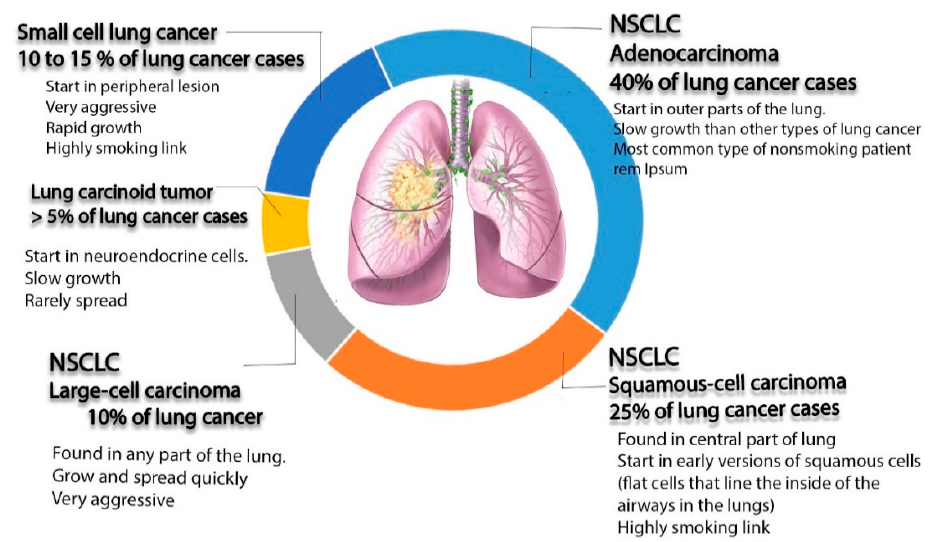
Figure 1. Schematic diagram illustrating different types of lung cancer (non-small cell lung cancer (NSCLC), small cell lung cancer (SCLC), and lung carcinoid tumors, as well as non-small cell lung cancer).